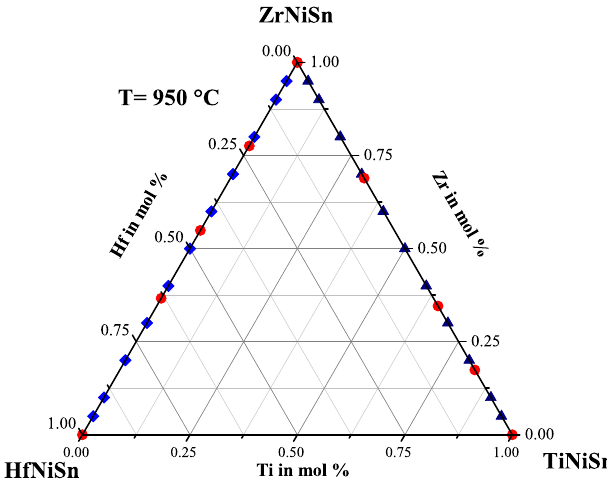
Figure 6. The Ti ( 1 − x ) Zr x NiSn series with the detected phases indicated in the Gibbs triangle.